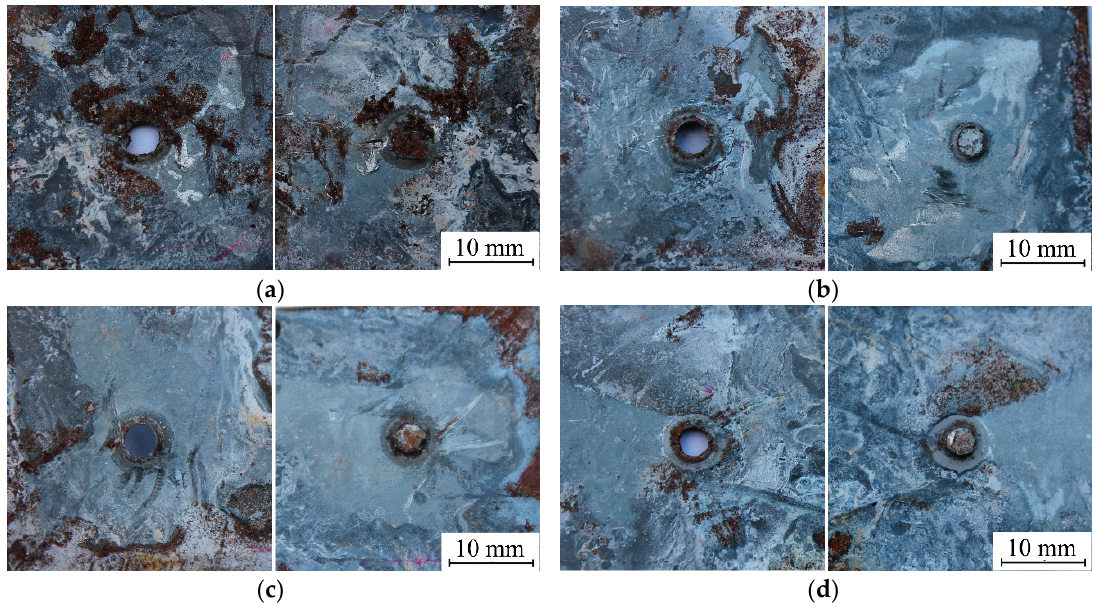
Figure 8. Surfaces of the spot welds at the internal sheet interface side after an exposure time of 500 h to a salt spray environment. Samples ( a ) no. 1; ( b ) no. 2; ( c ) no. 3; and ( d ) no. 4.